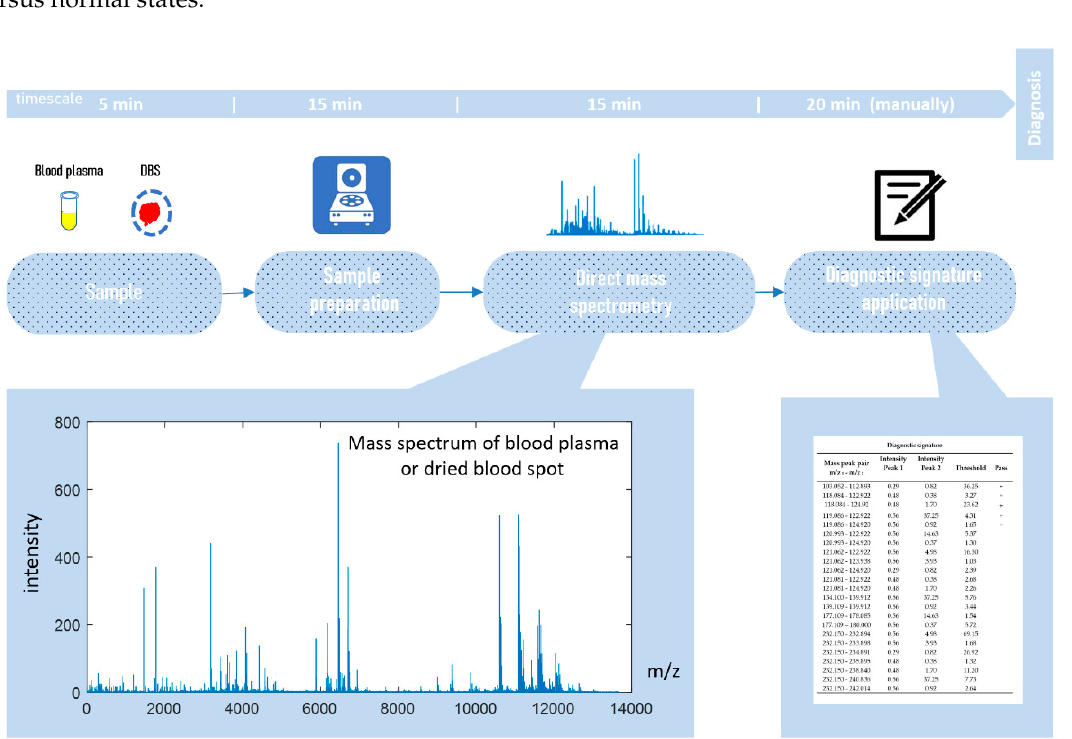
Figure 2. Schema to compile a label-free diagnostic signature based on direct-infusion mass spectrometry data. ROC: receiver operating characteristic; AUC: area under ROC curve.